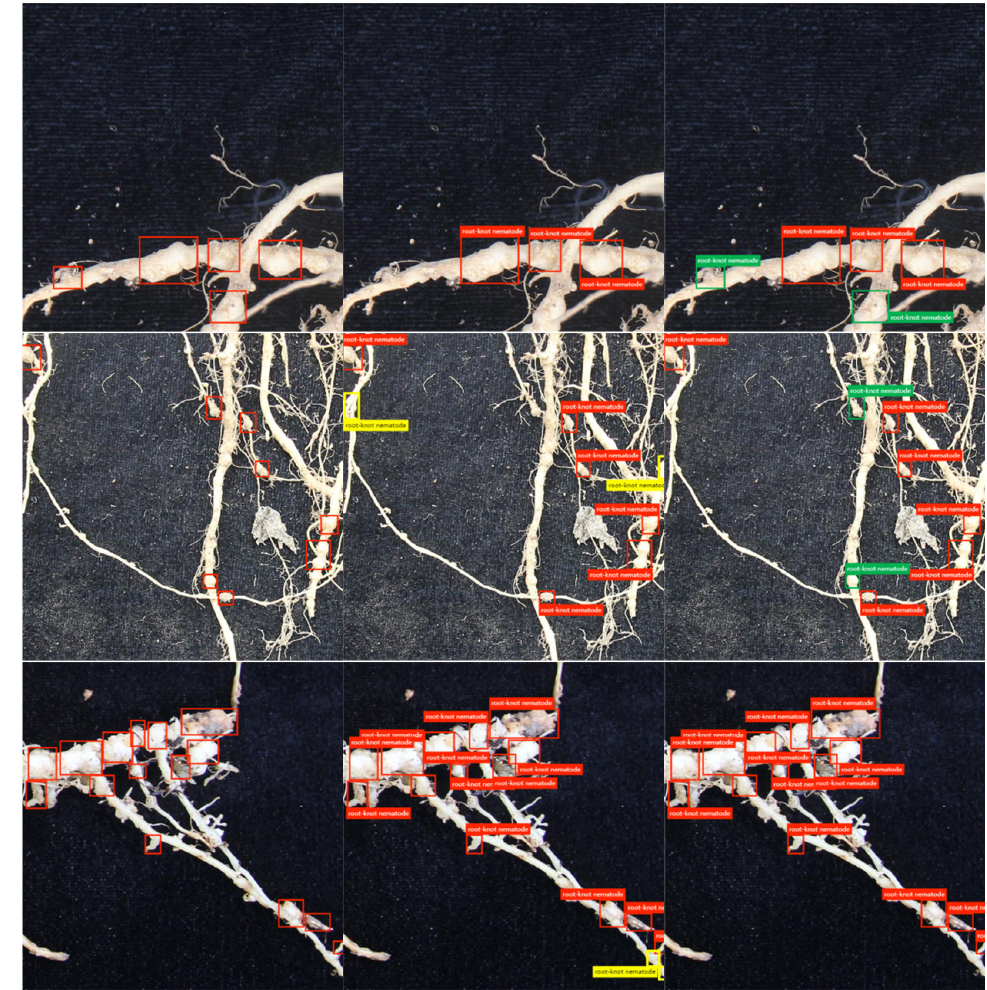
Figure 10. Comparison of partial detection results between YOLOv5s-CMS and YOLOv5s.